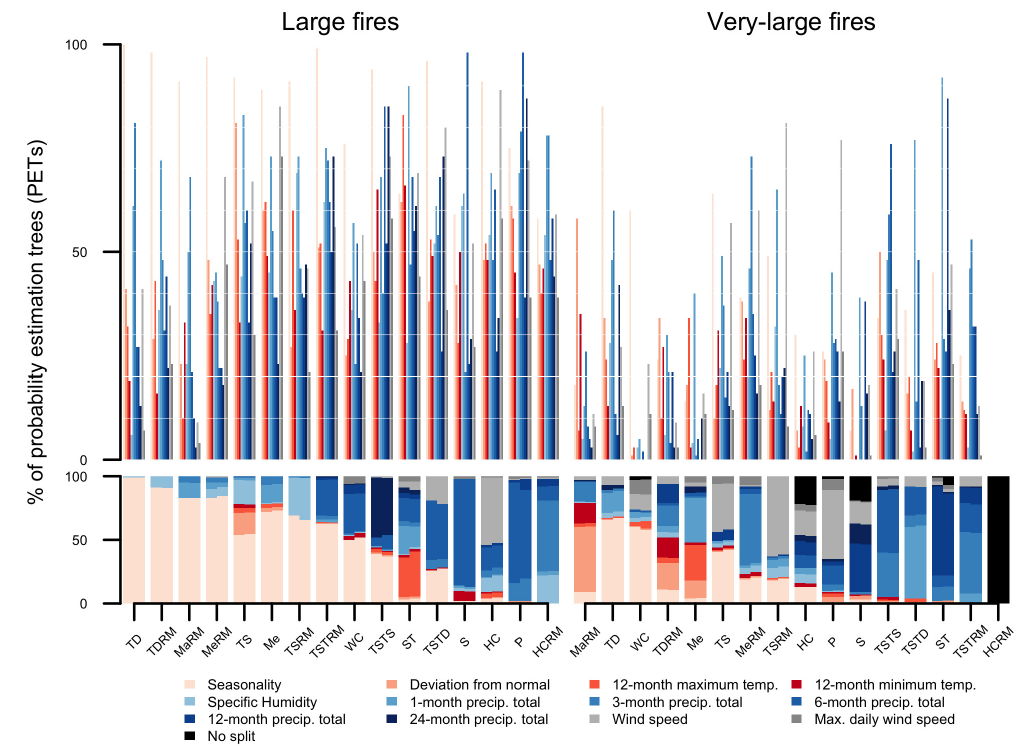
Figure 3. Summary statistics of each forest of probability estimation trees. The top panels show the percentage of probability estimation trees (PETs) in each forest that uses a particular weather predictor for at least one split. The bottom panels show the percentage of PETs for which a weather predictor is selected as the optimal splitting criterion. The relative contribution of each first-split variable under the unweighted (left) and weighted (right) averaging methods are displayed